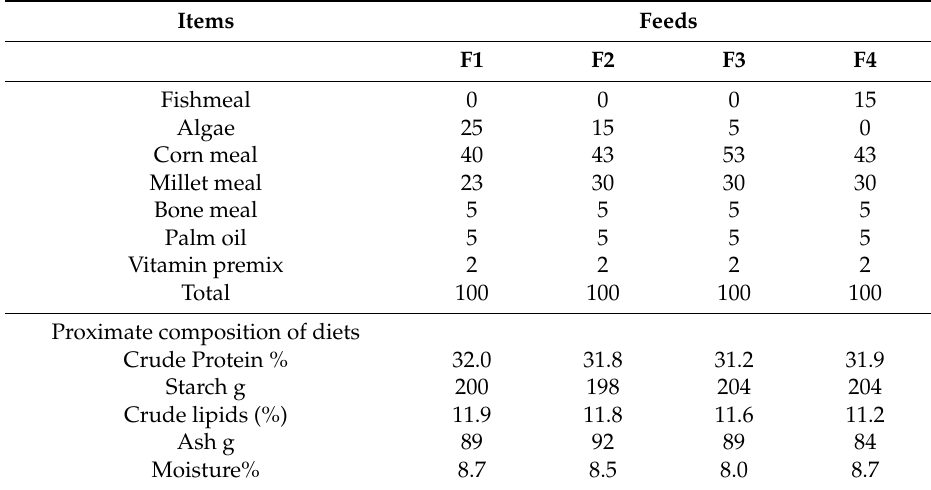
Table 2. Composition of experimental diets varying in the composition of freshwater algae Chlorella vulgaris used in feeding African catfish C. gariepinus for 60